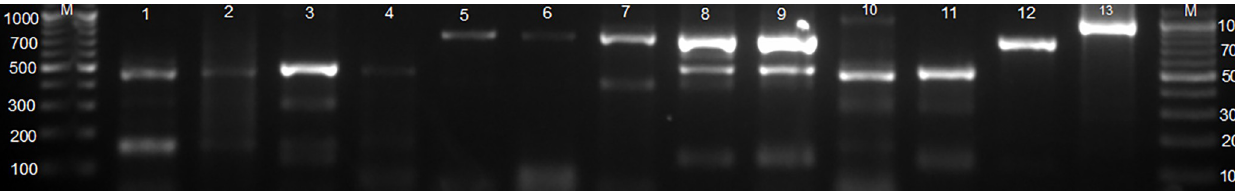
Fig 3. Agarose gel electrophoresis for AMOS PCR products amplified from cultures of tissues from slaughtered cattle. Lanes M: Gene Ruler 100 pb plus (ThermoFischer Scientific, Johannesburg, South Africa), lanes 1–4: Brucella abortus (496 bp), lanes 5–7: B . melitensis (731 bp), Lanes 9–10: mixed B . melitensis and B . abortus , lane 11: negative control containing sterile water, lane 12: positive control, B . abortus RF544, lane 13: positive control, B . melitensis rev 1.